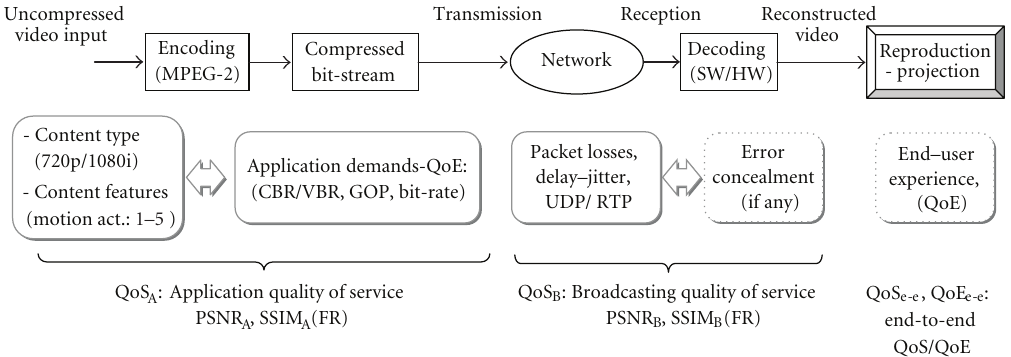
Figure 2: System simulation setup for performance evaluation by means of QoS and QoE